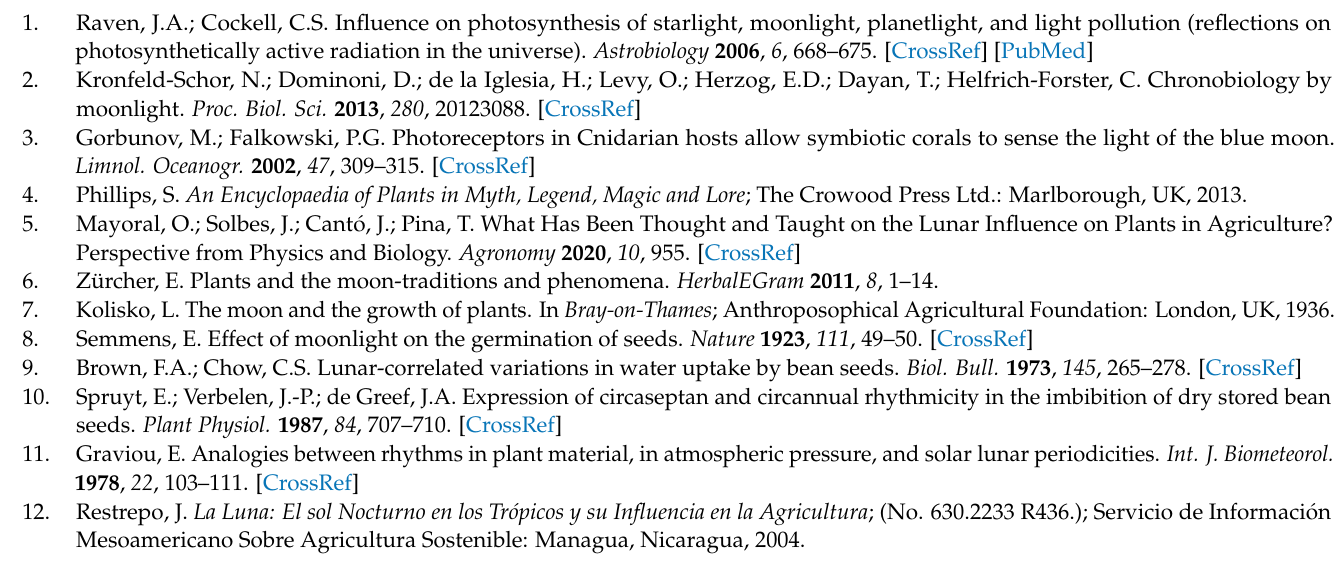
metabolites. Figure S3. Examination of light pollution at the experimental location. Figure S4. FML and light induced increase in nuclear size/volume in B. juncea seedlings. Figure S5. Removal of 10 or 20 amino acids of H3.3 C terminus resulted in loss of α 3 helix. Supplementary tables: Table S1. List of metabolites present in treated plants (FML and dark). Table S2. List of metabolites present in treated plants (NM and dark). Table S3. List of all proteins (raw data) present in treated plants (FML and dark). Table S4. List of expressed proteins present in treated plants (FML and dark) after filtering. Table S5. Differentially expressed proteins between FML- and dark-treated